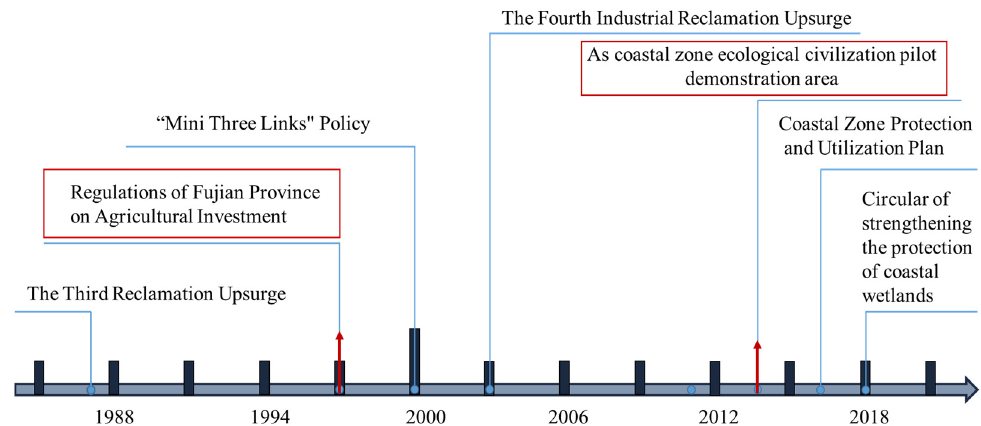
Figure 9. The relative policies issued by governments over the past decades.